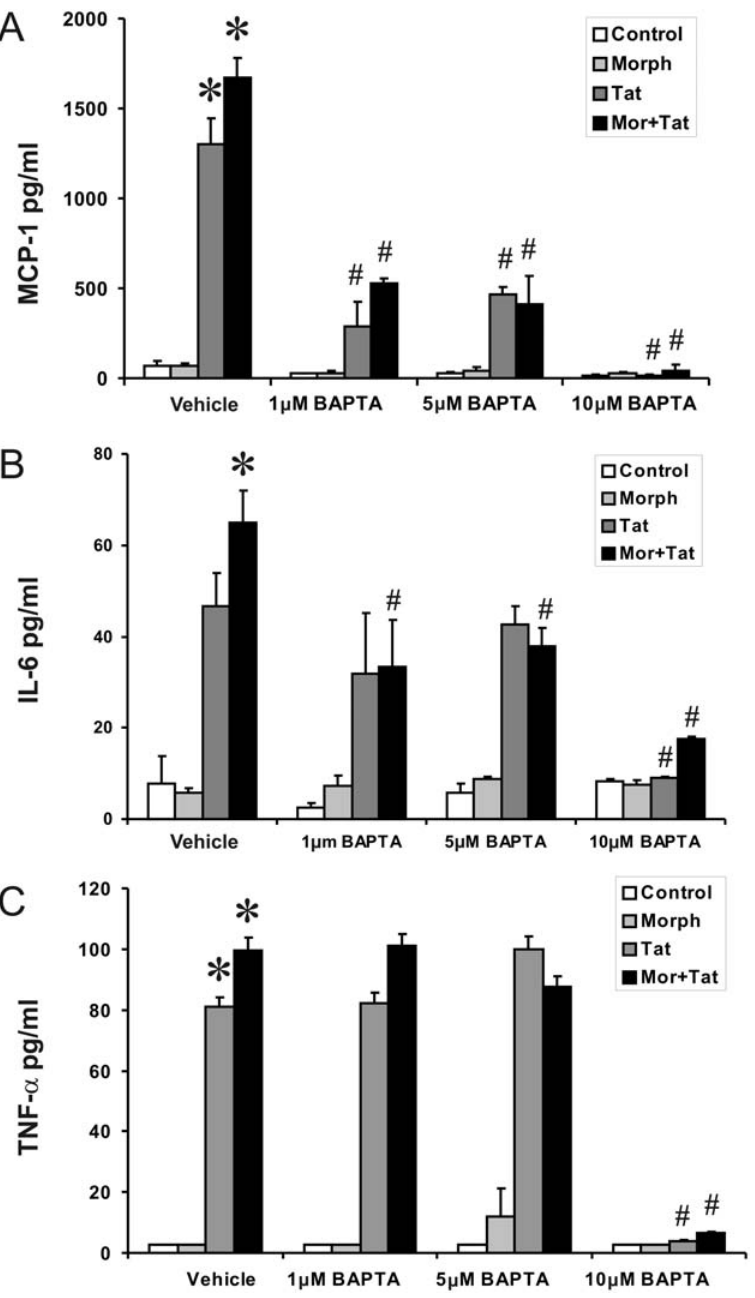
Figure 4. Effects of BAPTA on Tat 6 morphine-induced cytokine release by astrocytes. Buffering [Ca 2 + ] i blocked Tat 6 morphine (Morph or MOR) induced cytokine release by astrocytes at 6 h. Stimulation with Tat 6 morphine caused significant increases in MCP-1, IL-6, and TNF- a production compared with untreated controls (A–C). The Ca 2 + chelator BAPTA caused significant, concentration-dependent reductions in the release of MCP-1, IL-6 and TNF- a by astrocytes. Results are representative of 3 independent experiments, and the data are given as the mean 6 SEM at 6 h (* P , 0.05 vs. vehicle-treated controls; # P , 0.05 vs. identical treatment without BAPTA). doi:10.1371/journal.pone.0004093.g004 PLoS ONE |